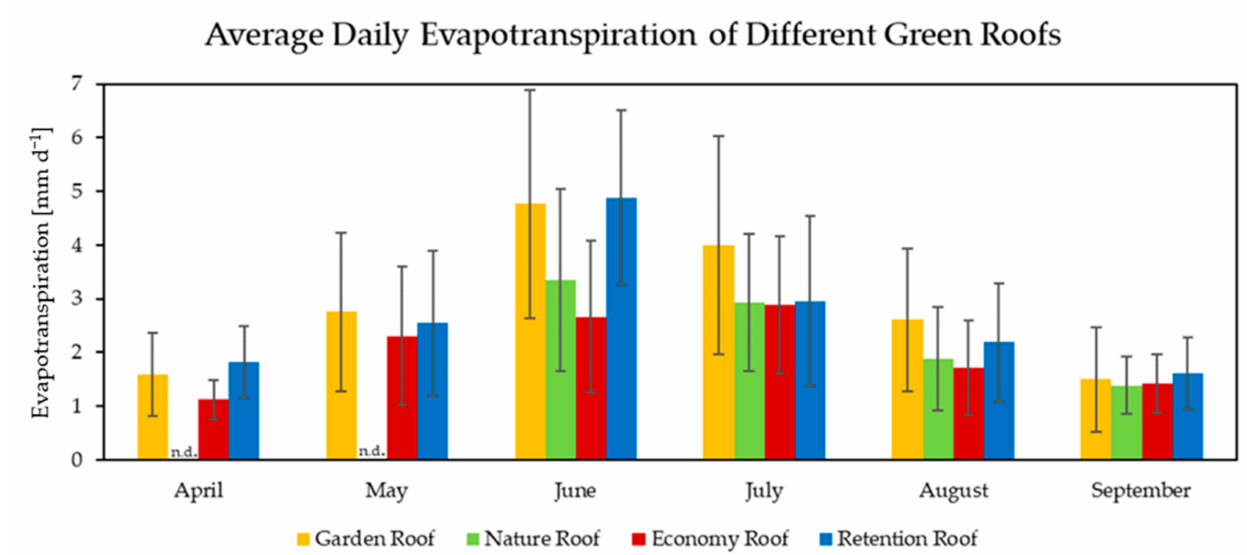
Figure 7. Average daily evapotranspiration of the four different green roofs with means ± SD from April to September 2021. October is not included here as data were only available for four days in that